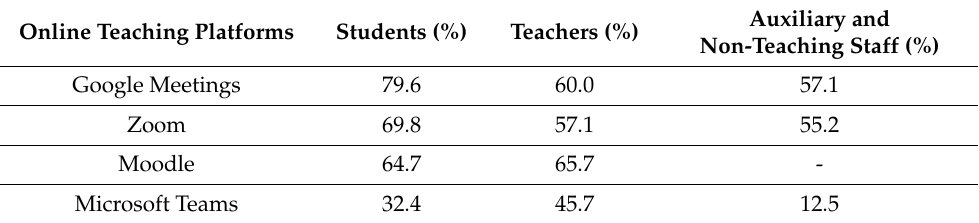
Table 7. Online teaching platforms used by the key internal